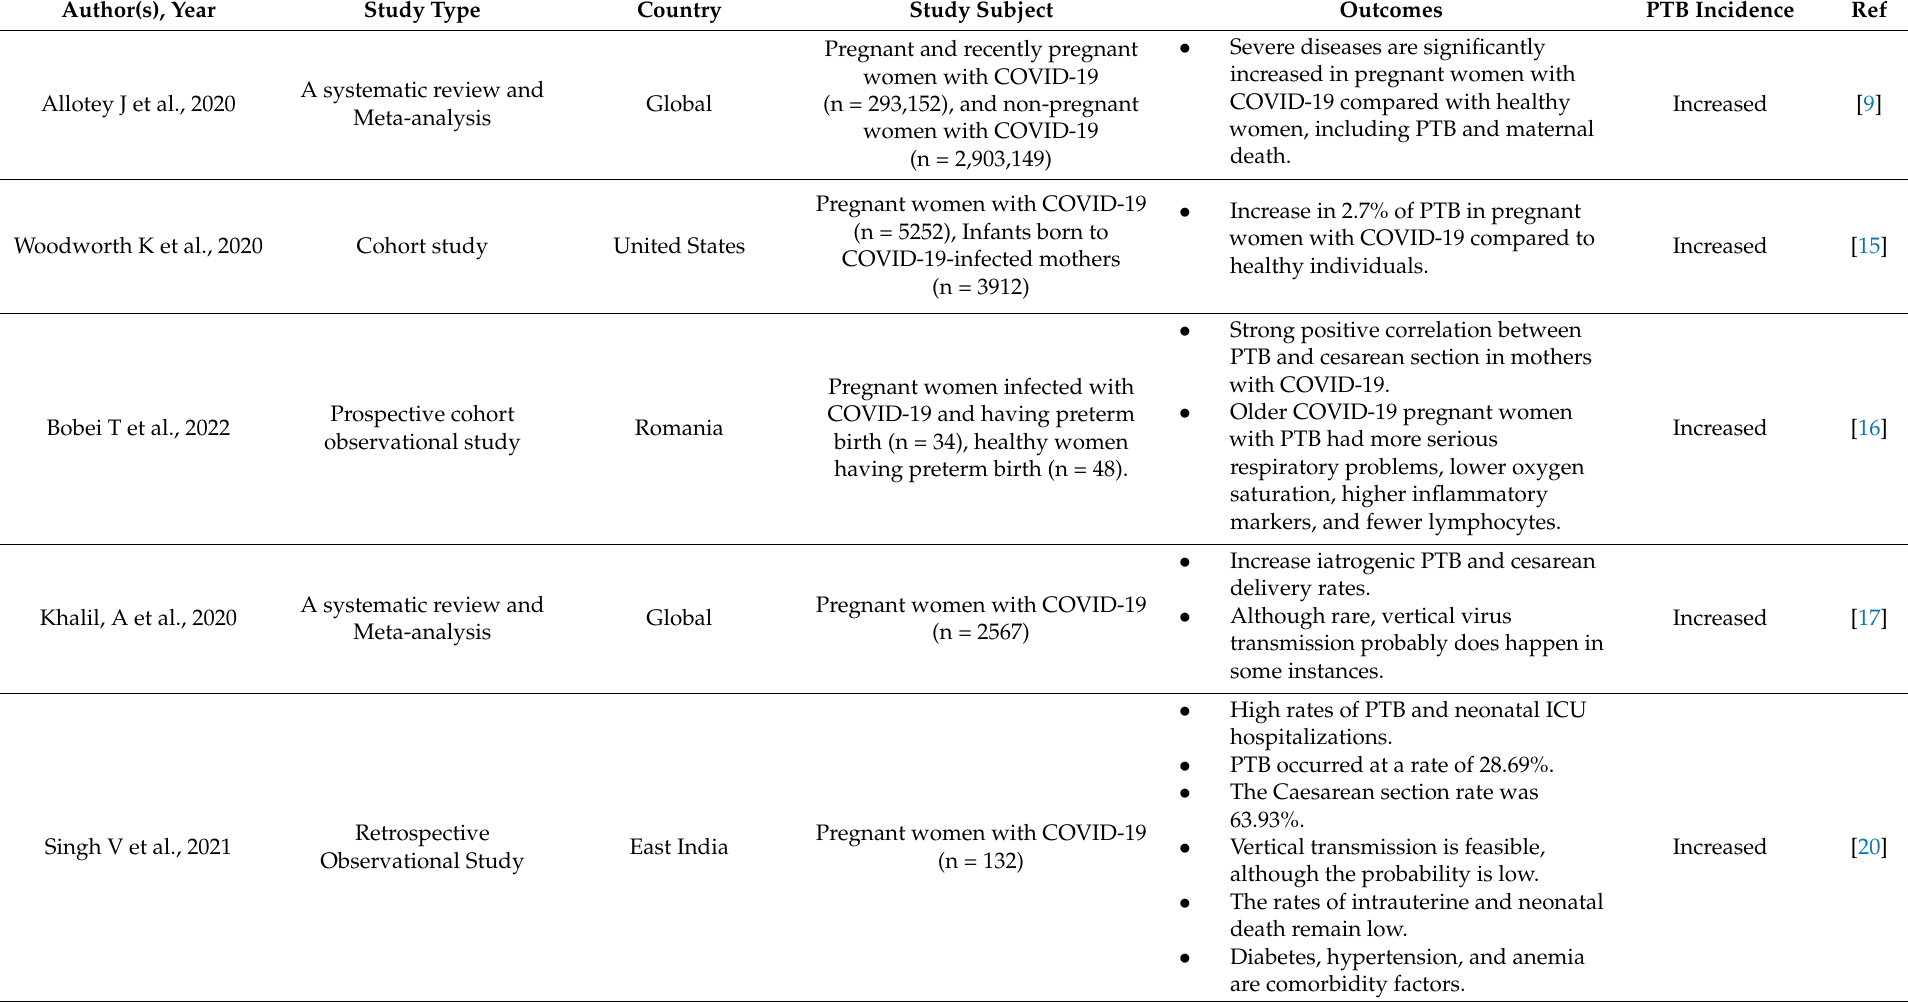
Table 1. A summary of some studies reporting the outcomes and incidence of preterm deliveries in the era of